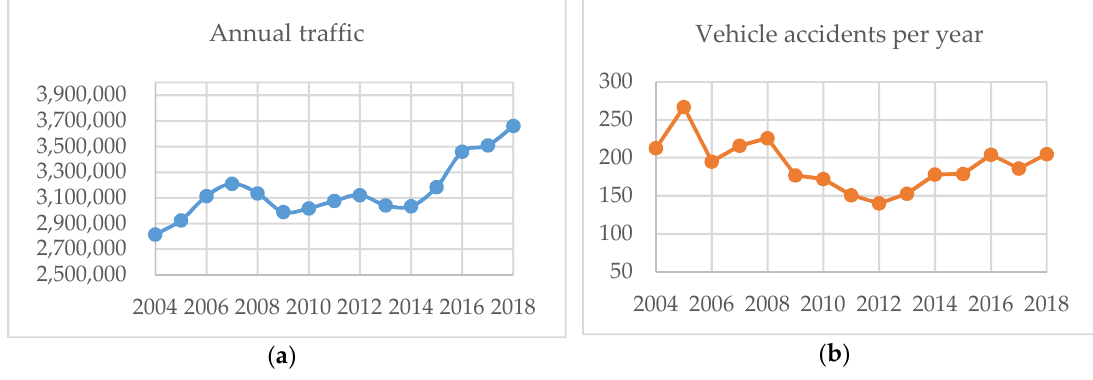
Figure 3. Annual traffic comparative and number of accidents: ( a ) annual traffic in the highway 2004–2018; ( b ) vehicle accidents per year in the highway 2004–2018.